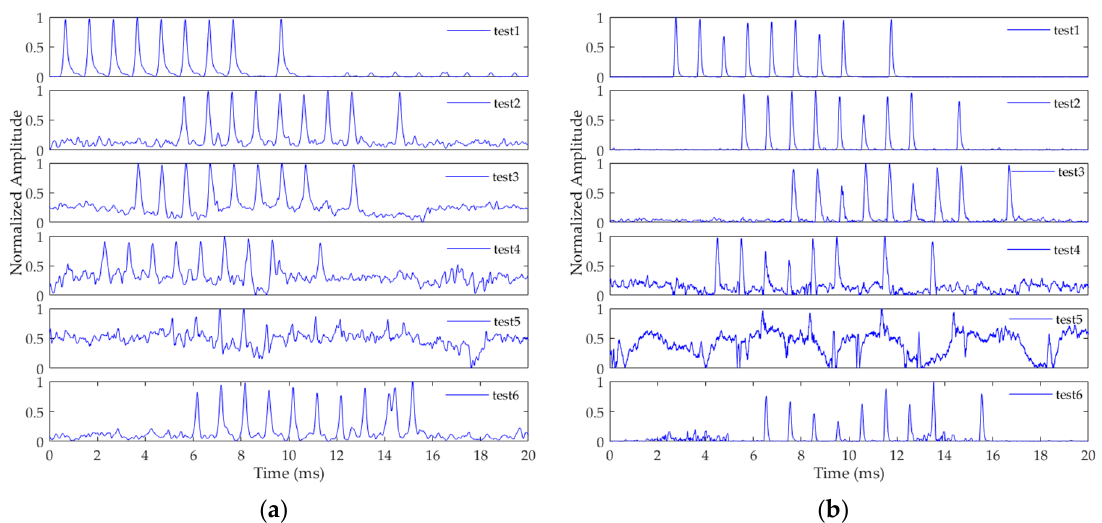
Figure 15. Test results of existing methods with respect to actual data: ( a ) the matched filter method based on Loran-C pulses signal [13]; ( b ) the delay correlation acquisition method based on Loran-C pulses signal [16].